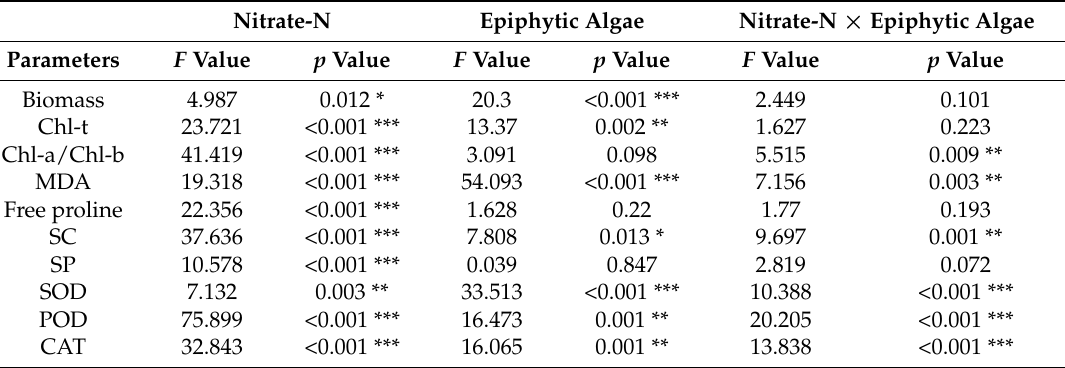
Table 1. Results of two-way ANOVA on the effects of increasing nitrate-N and epiphytic algae on the biomass and physiological parameters of V. natans. SC and SP, respectively, represent